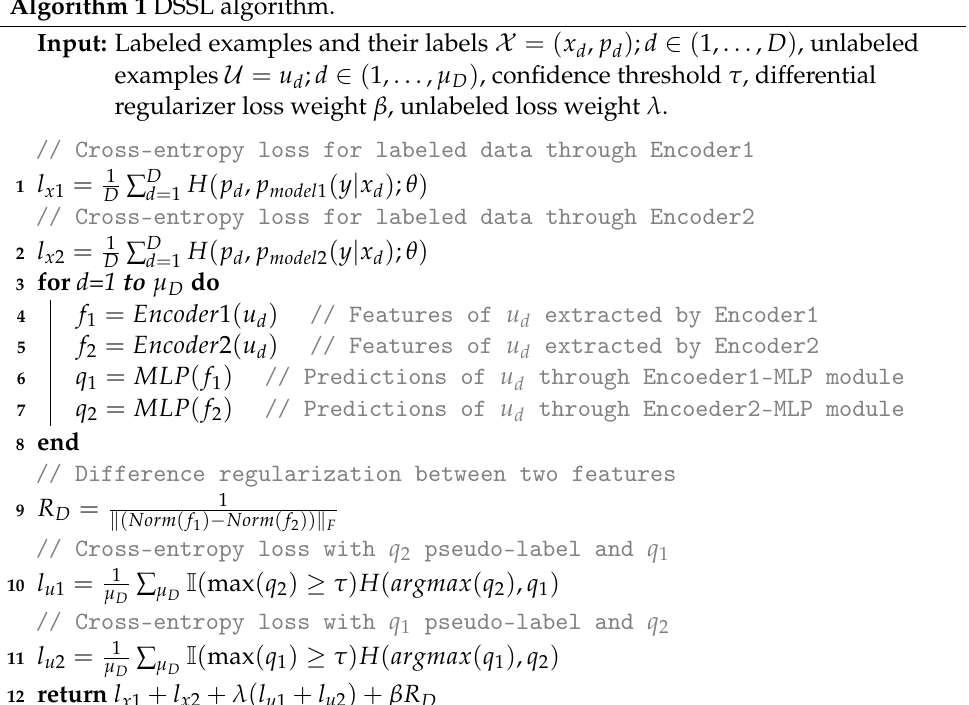
Algorithm 1 DSSL